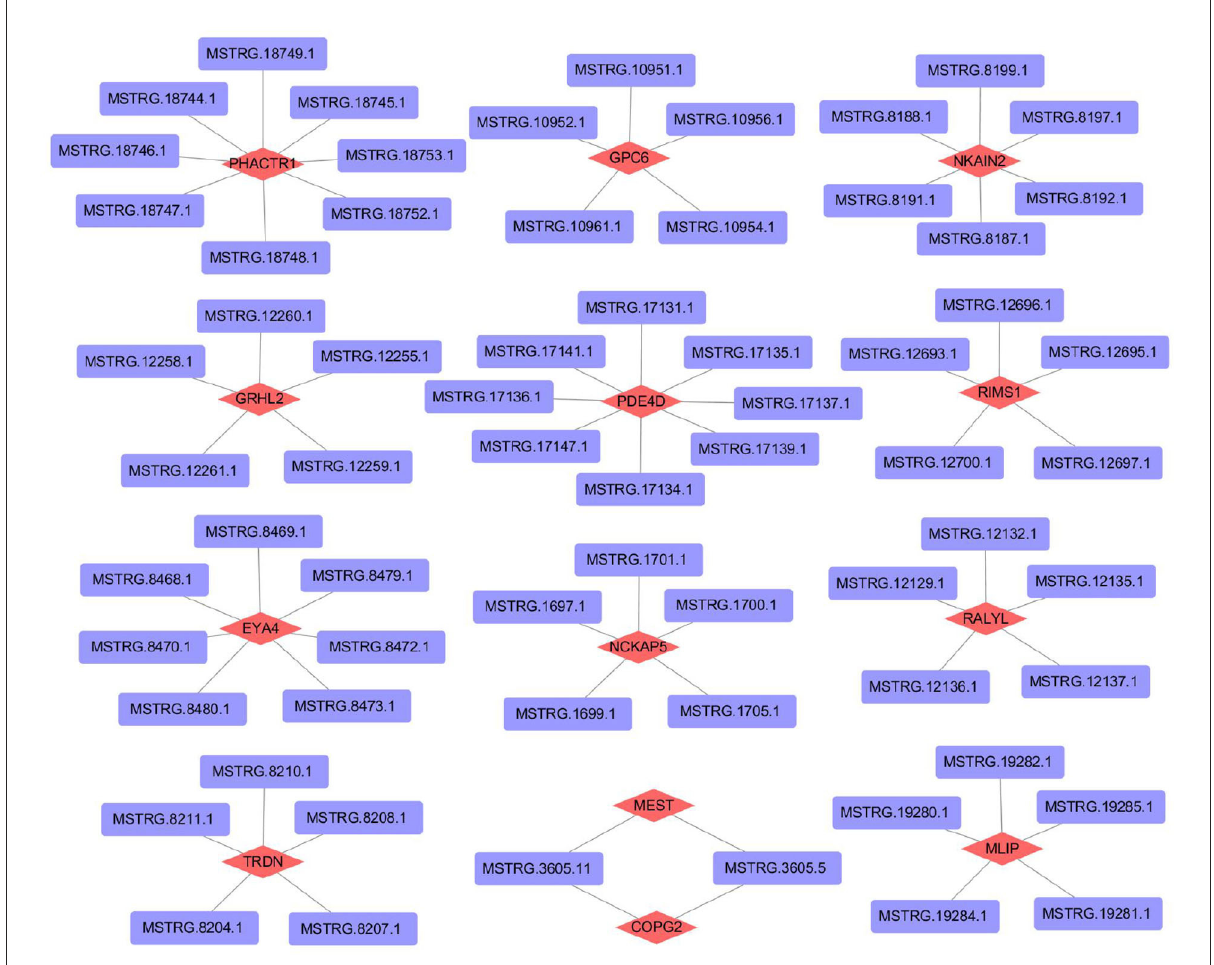
(Figure 5). The results are as follows: d45 vs. d55, lncRNA upregulated by 75 and downregulated by 82; d45 vs. d65, lncRNA upregulated by 291 and downregulated by 511; d45 vs. d75, lncRNA upregulated by 277 and downregulated by 393; d55 vs. d65, lncRNA upregulated by 315 and downregulated by 492; d55 vs. d75, lncRNA upregulated by 268 and downregulated by 360; d65 vs. d75, lncRNA upregulated by 110 and downregulated by 67 (Figure